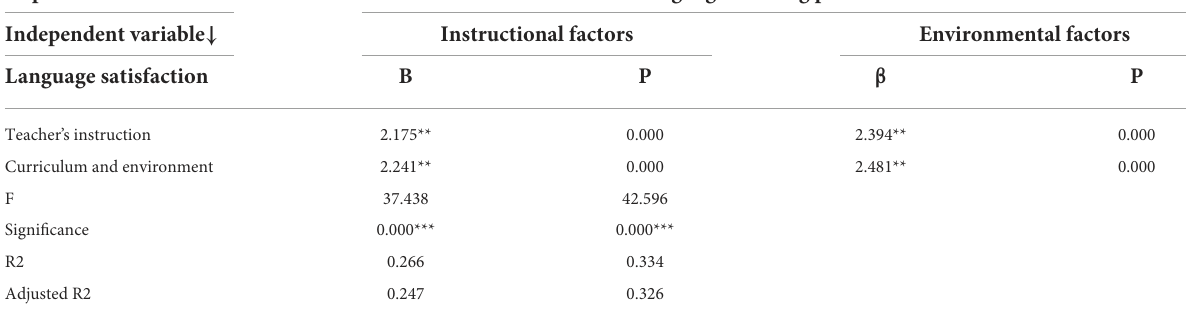
TABLE 3 Analysis of language satisfaction to language learning